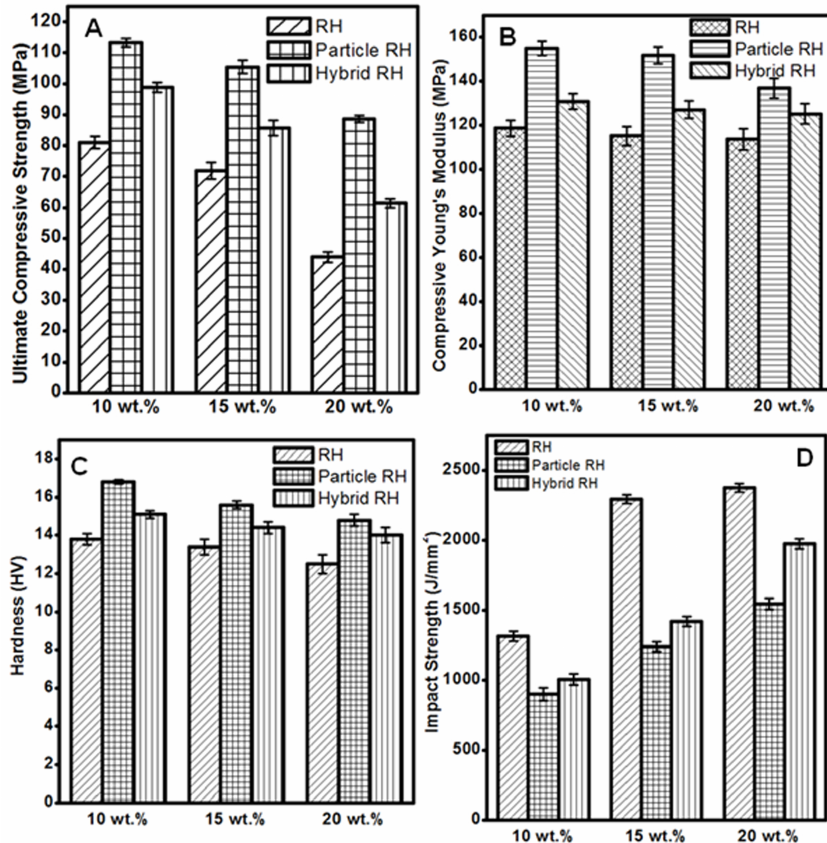
Figure 4: (A) Ultimate compressive strength, (B) Compressive Young’s modulus, (C) Hardness and (D) Impact energy Table 1: ANOVA data for thrust force and torque for powder RH reinforced Composite ANOVA analysis for thrust